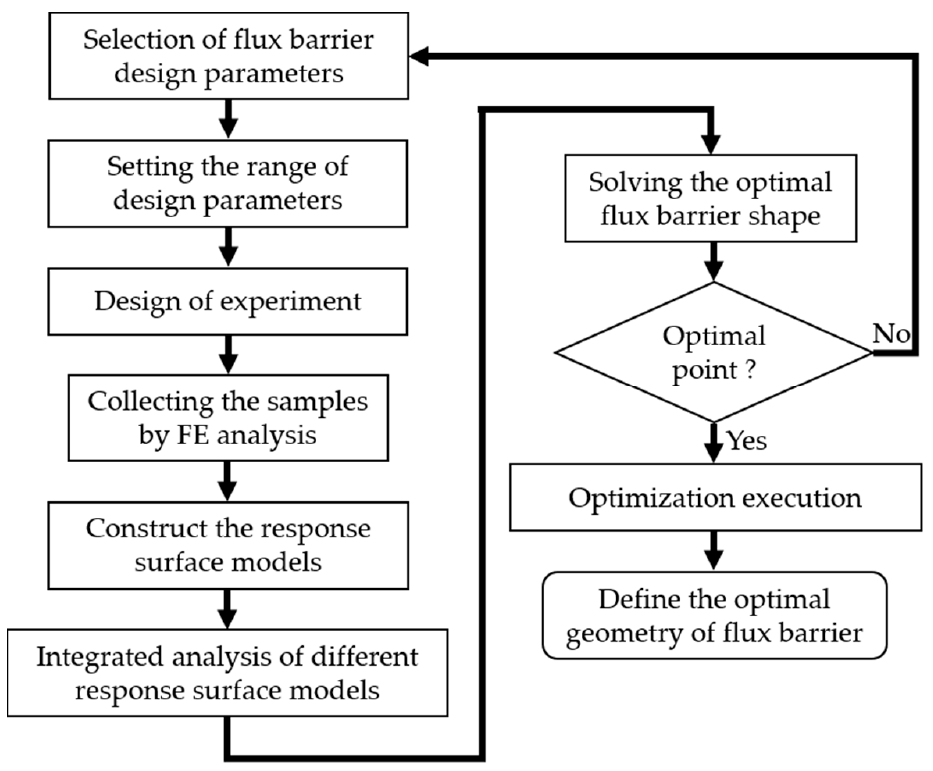
Figure 4. A flowchart of design process using RS methodology.